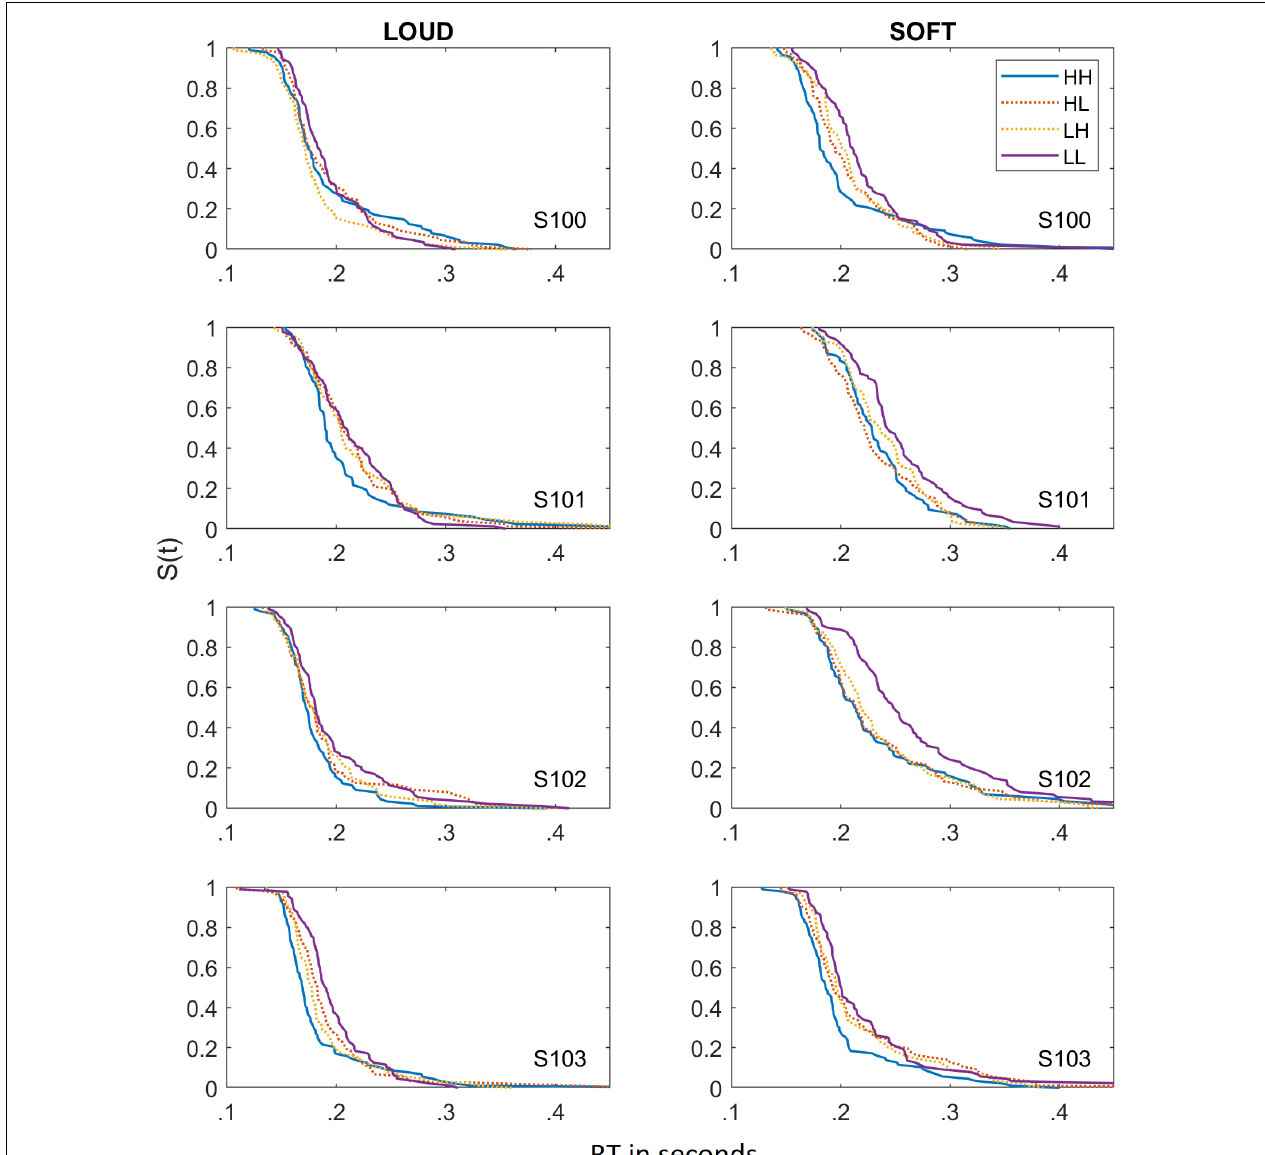
FIGURE 2 | Survivor functions obtained for the dual-target stimuli for the LOUD scenario (left panels) and the SOFT scenario (right panels) . Data from the different dual-target conditions (HH, HL, LH, and LL) are depicted by lines of different colors and solid lines indicate HH and LL whereas dotted lines reference HL and LH.